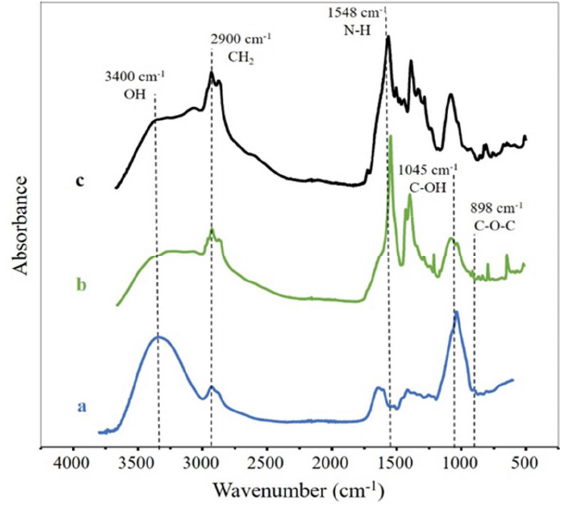
Figure 3. FTIR spectra of AX ( a ), AX-f ( b ), and basal medium (culture medium with no added carbon source) ( c ).